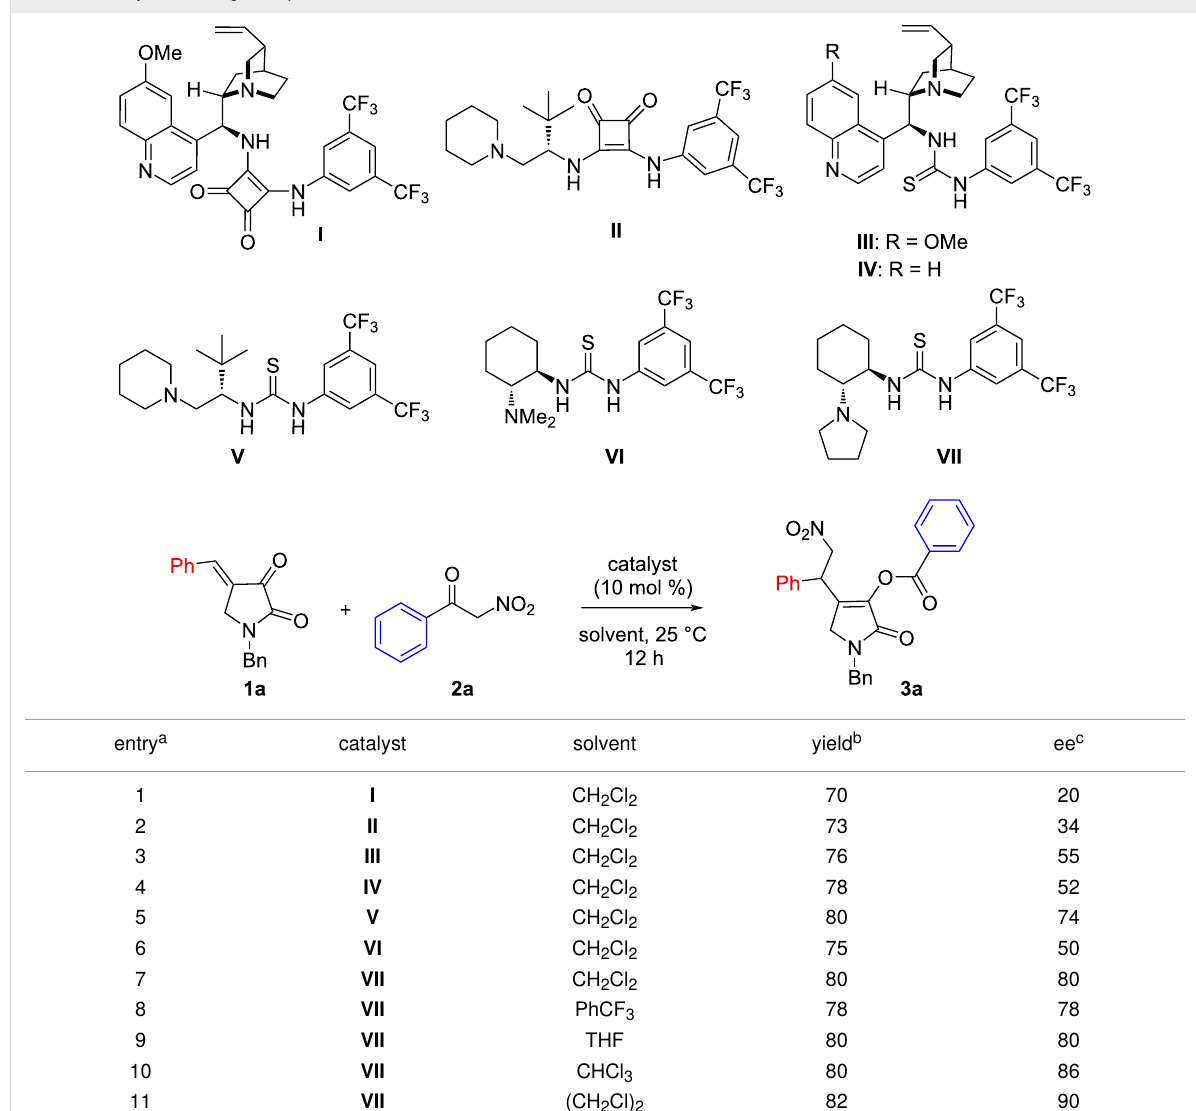
Table 1: Catalyst screening and optimization of the reaction